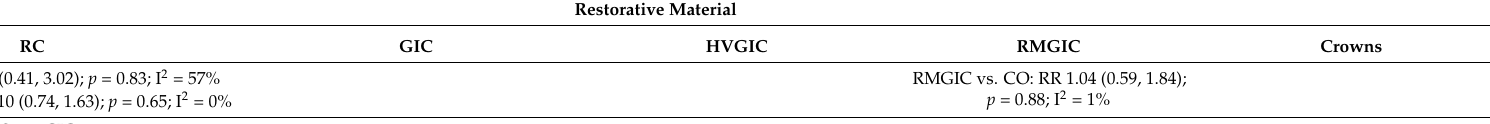
Table 4. Main results from the meta-analysis of included reviews with a quantitative synthesis of the